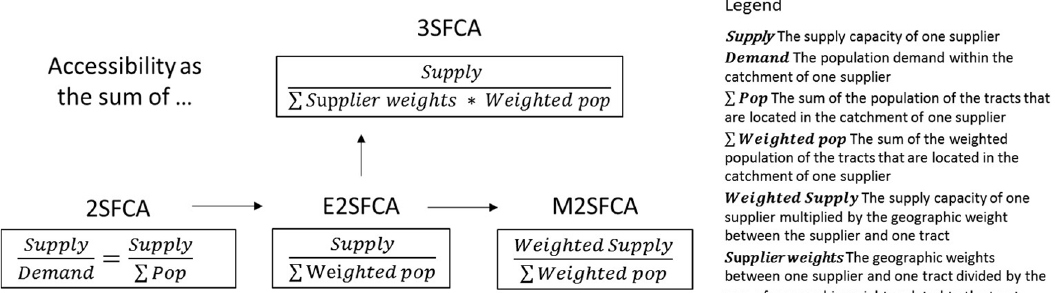
Figure1.Thedevelopmentoffloatingcatchmentarea(FCA)methods,whereE2SFCAistheenhancedtwo-step FCA, M2SFCA is the modified two-step FCA, 3SFCA is the three-step FCA, and 2SFCA is the flow-based method. The adaptation of geographic weights has continued throughout the